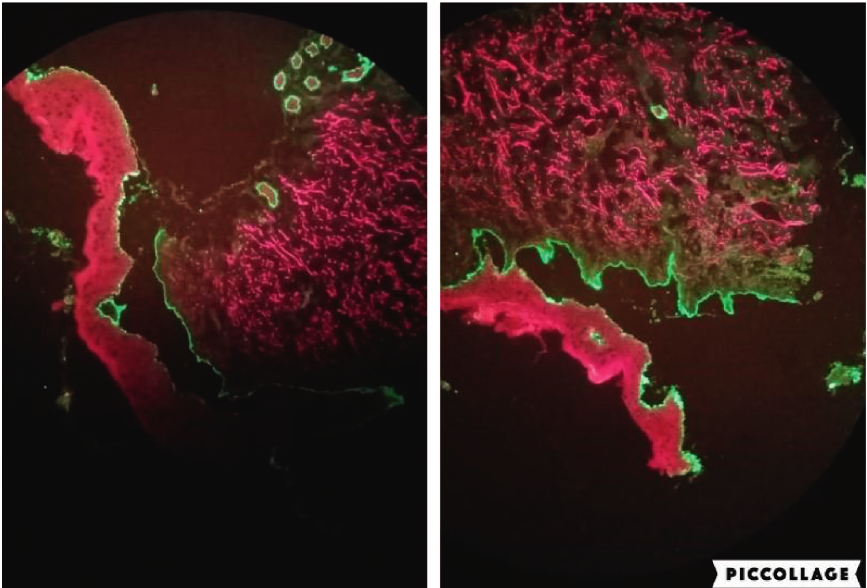
Figure 3: Linear deposition of IgG and C3 at